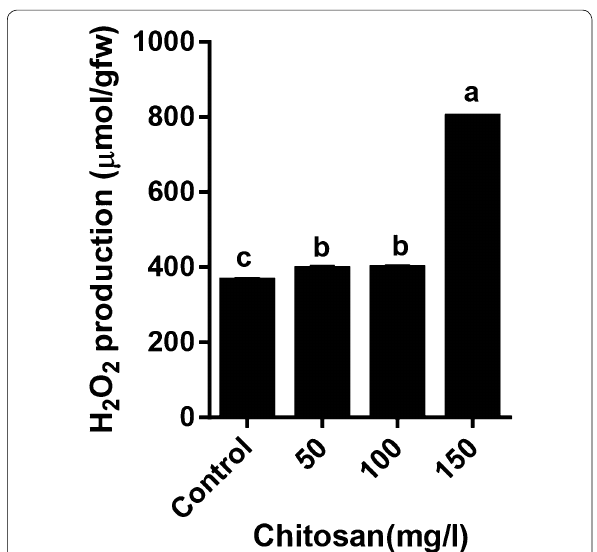
Fig. 2 Effect of chitosan levels on H 2 O 2 content of Melissa officinalis shoot cultures. Each value is expressed as mean Differences were significant at p < 0.05 level (one-way ANOVA followed by LSD test)